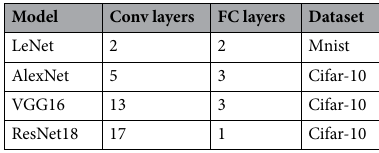
Table 2. Neural network